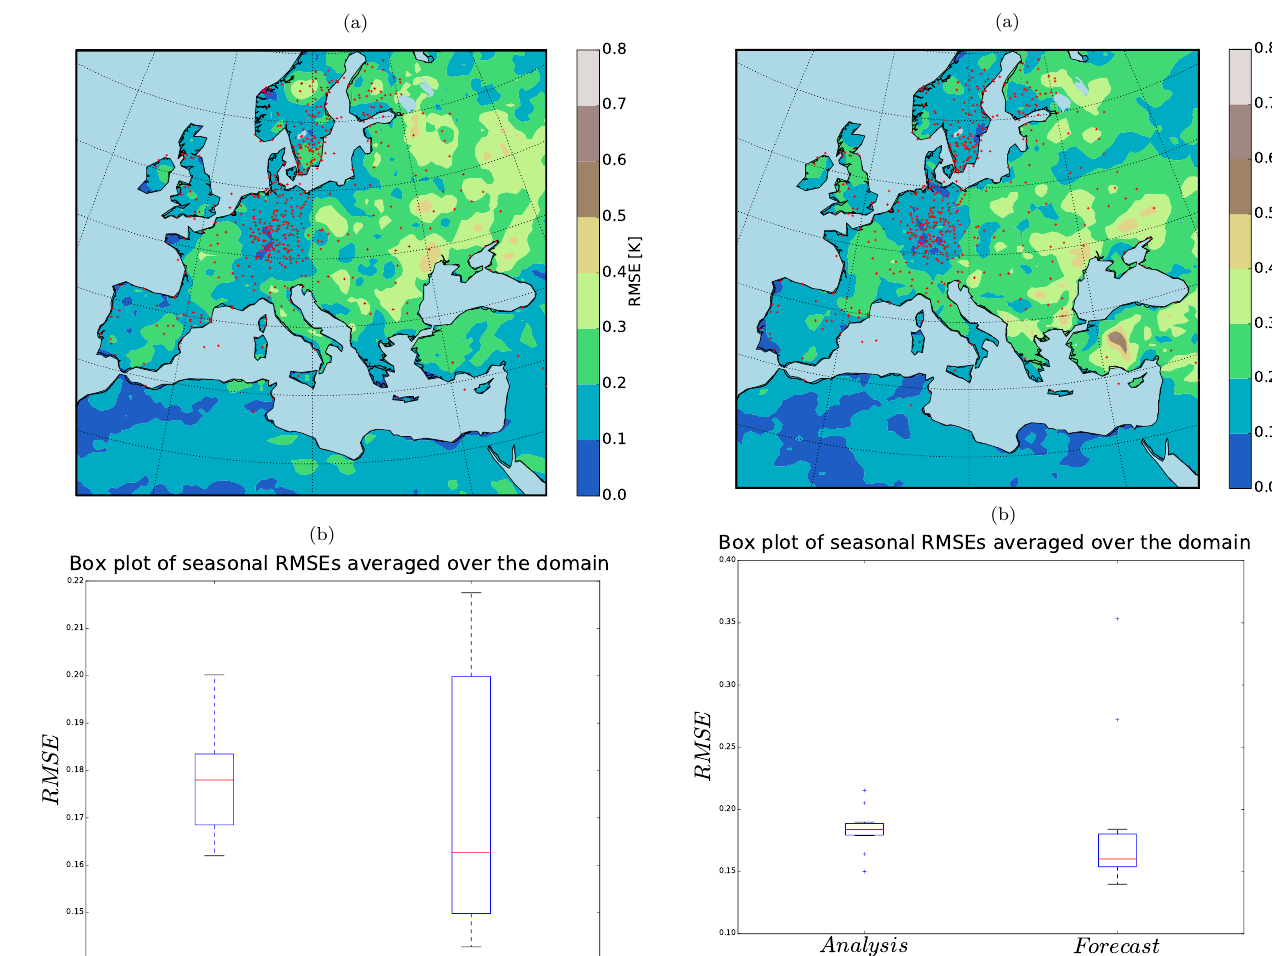
Figure 6. (a) 10-year RMSE (K) of the analysis for winter (DJF) with and (b) the field mean RMSE (K) of the analysis and the free ensemble run for winter